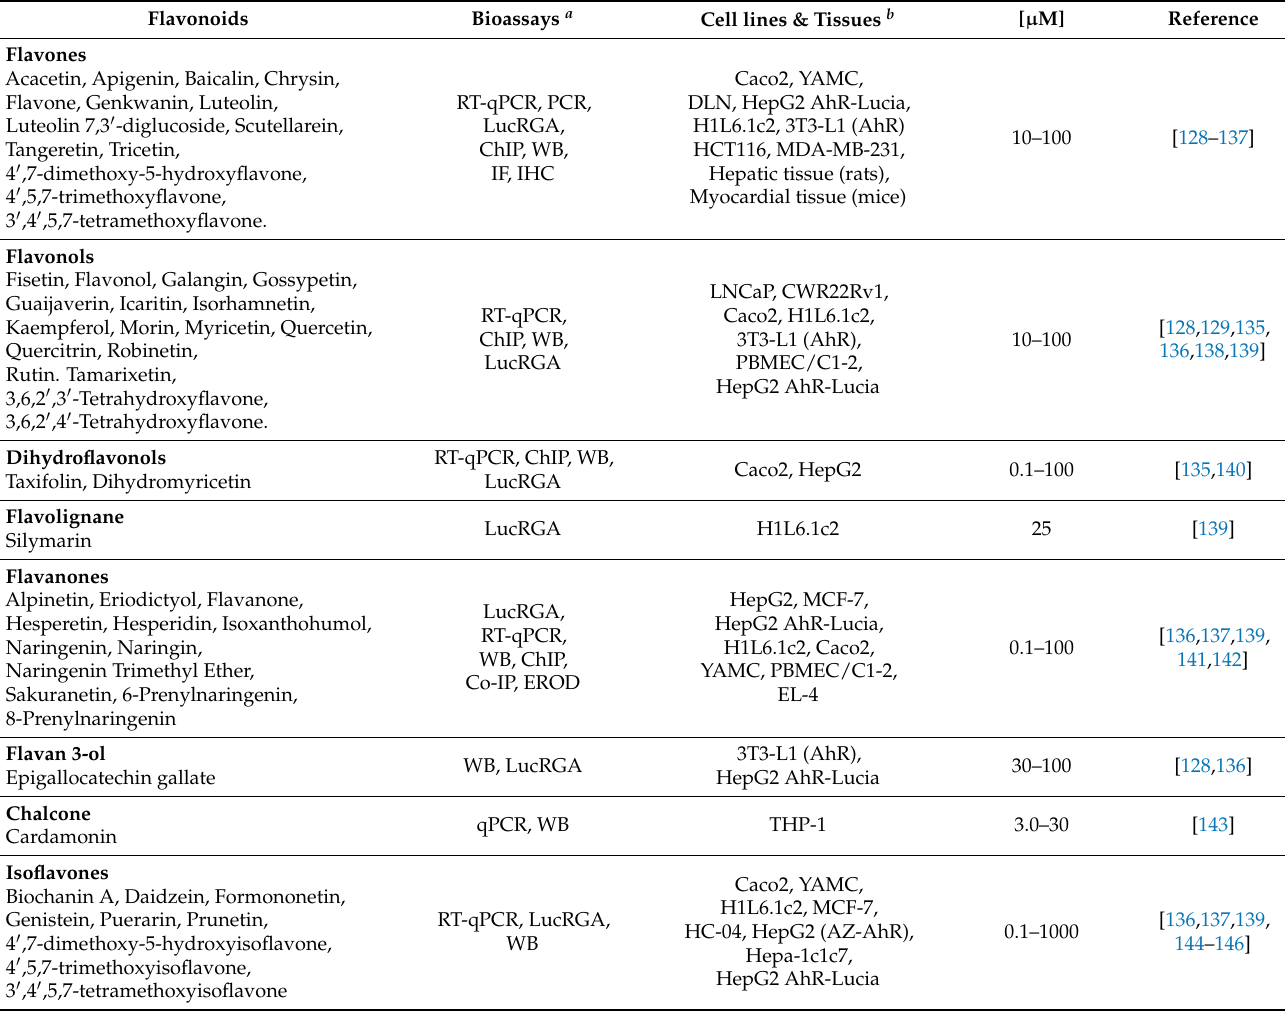
Table 1. Plant occurring flavonoids studied as aryl hydrocarbon receptor (AhR) modulators through different bioassays. Flavonoids Bioassays a Cell lines & Tissues b [ µ M] Reference